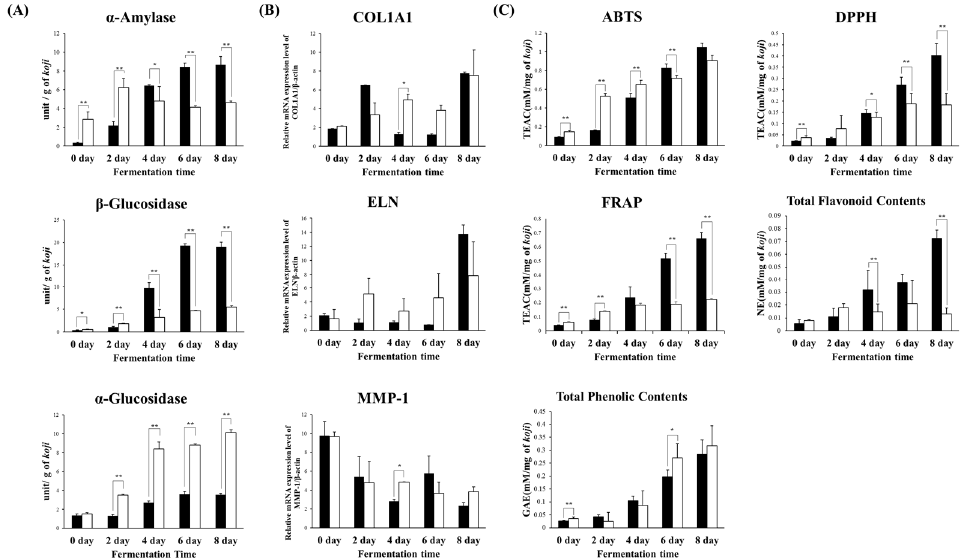
Figure 3. Comparison of enzyme production ( A ), skin anti-aging factor ( B ) and antioxidant activity, total flavonoid contents (TFC), total phenolic contents (TPC) ( C ) in rice koji fermented with different Aspergillus spp . (black color, A. cristatus ; white color, A. oryzae ). The enzymatic activities are α -amylase activity, β -glucosidase activity, and α -glucosidase activity ( A ). The relative mRNA expression level is measured for the following: collagen (COL1A1), elastin (ELN), and matrix metalloproteinase-1 (MMP-1) ( B ). The antioxidant activities depicted are ABTS, DPPH radical scavenging, FRAP, total flavonoid content, and total phenolic content ( C ). Significant differences between different inoculation microbes were identified by t -test (* p < 0.05, ** p < 0.01).